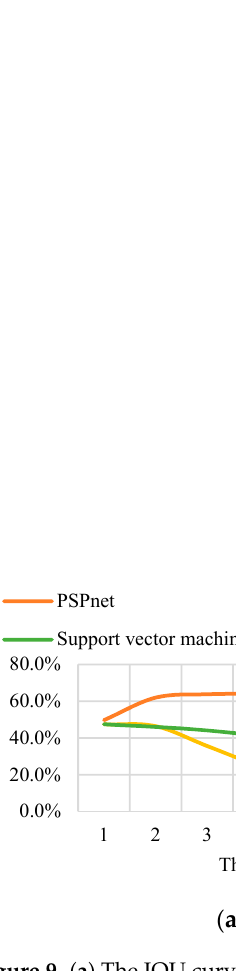
( f ) SVM; T = 7; S = 70 Figure 8. Binary images obtained by the different thresholds under three classification methods. Figure 8 shows the binary images of the three segmentation methods under the threshold levels of S = 70, and T = 3 and 7. The changes caused by the three different clas- sification methods under the same parameter show that the pixel range of PSPnet seg- mentation is more concentrated, followed by that of SVM segmentation. As shown in Fig-